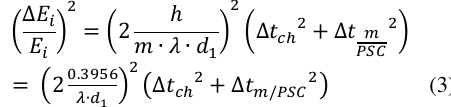
Fig. 3. Operation mode of multi-chopper instruments at different kind of sources. Reactor; a set of PSC and MC create monochromatic multi pulsed beam at a frequency of f. Long pulse source; it extracts RRM pulses with slightly different incident energies with a long flight distance. Short pulse; Only MC extracts well separated different incident